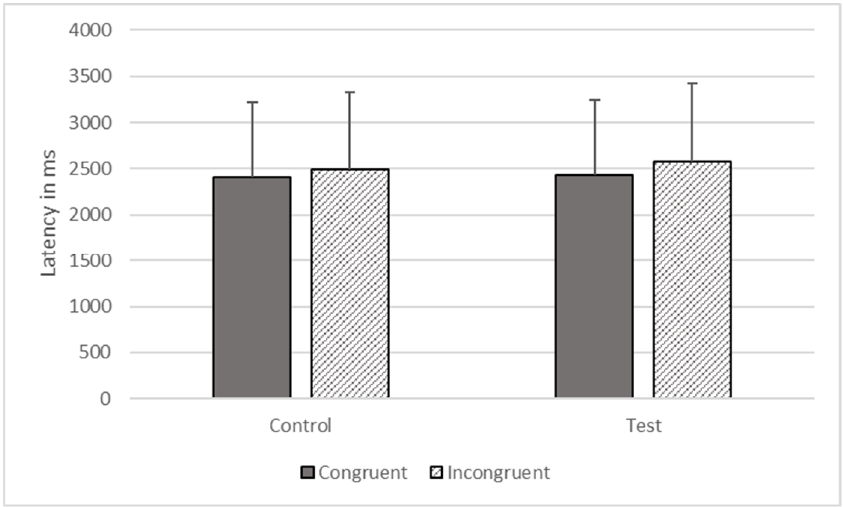
Figure 5. Response latencies as a function of trial types in Phase